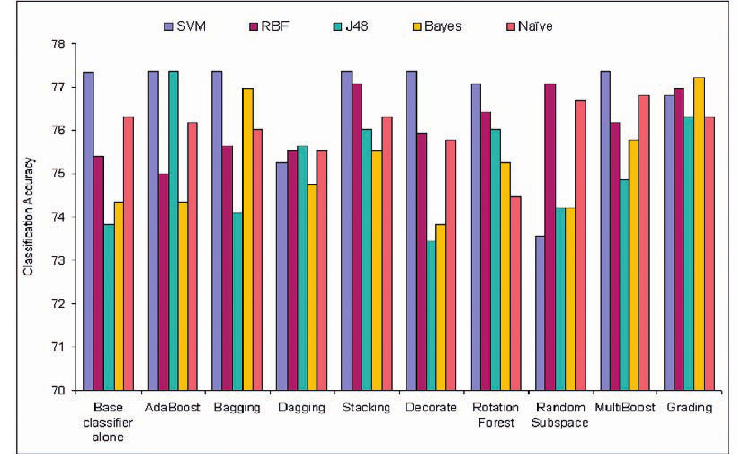
Figure 3. Classification accuracy of base classifiers alone vs. ensemble methods using D1.